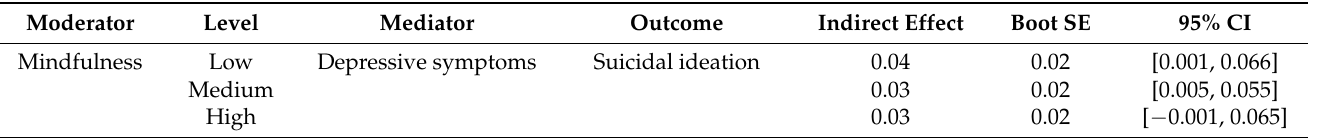
Table 3. Conditional indirect effects of harsh parenting on suicidal ideation through depressive